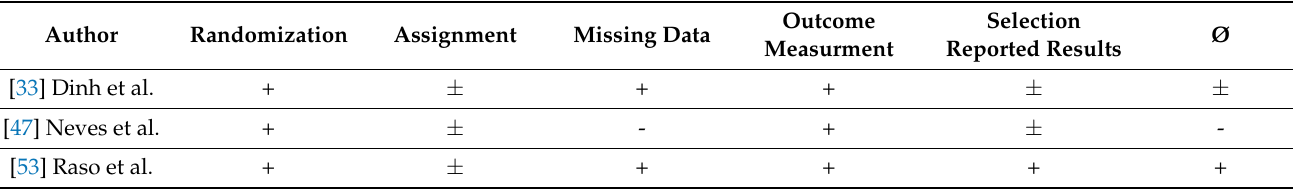
Table 9. Studies assessed using the RoB2 Tool ( n =